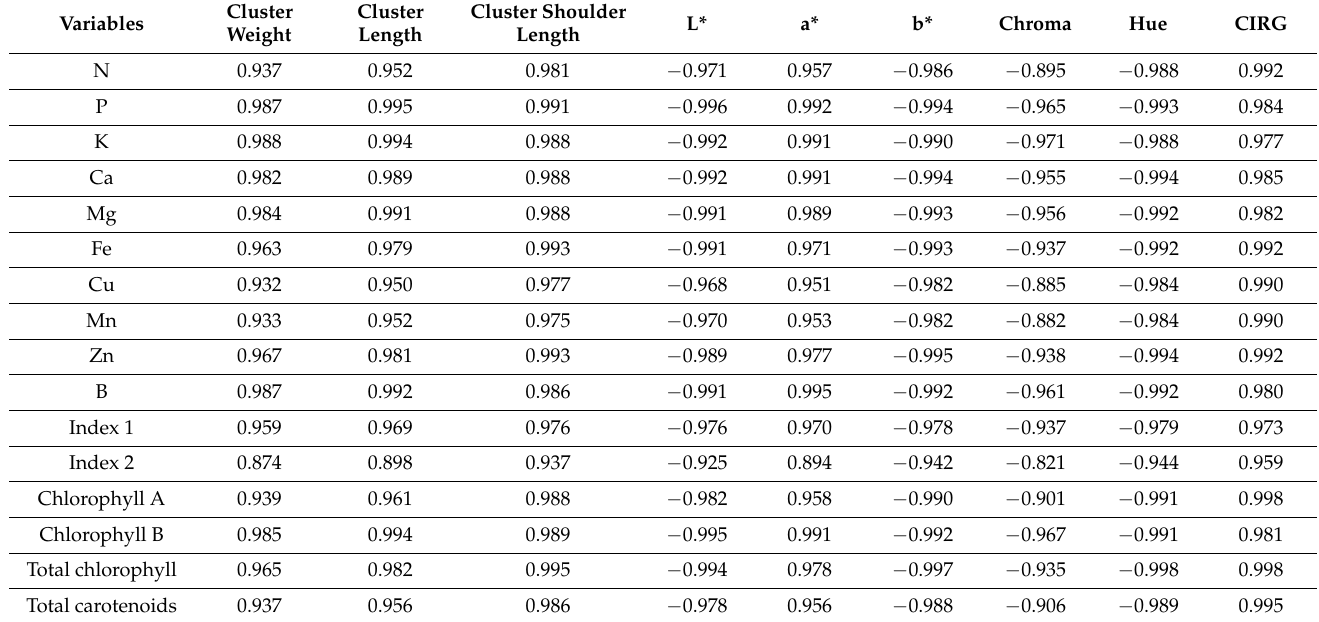
Table 6. Pearson’s correlation coefficients ( r ) describing the correlations of nutritional status, index 1, index 2 and Cluster attributes and berries’ color attributes of Flame Seedless grape cultivated by different agricultural